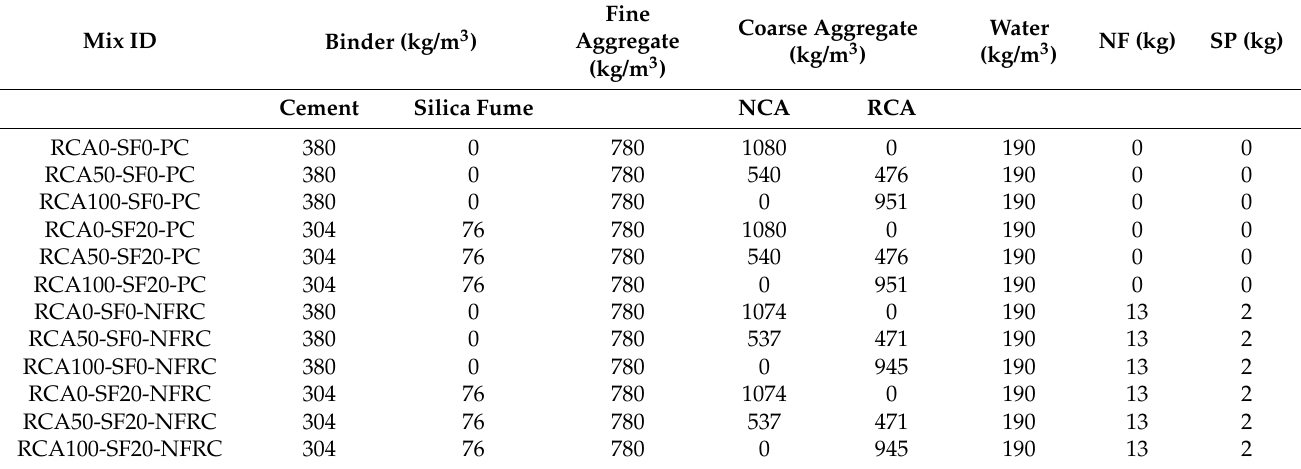
Table 5. Concrete Mixture Nomenclature and Ingredients Quantity in Cubic